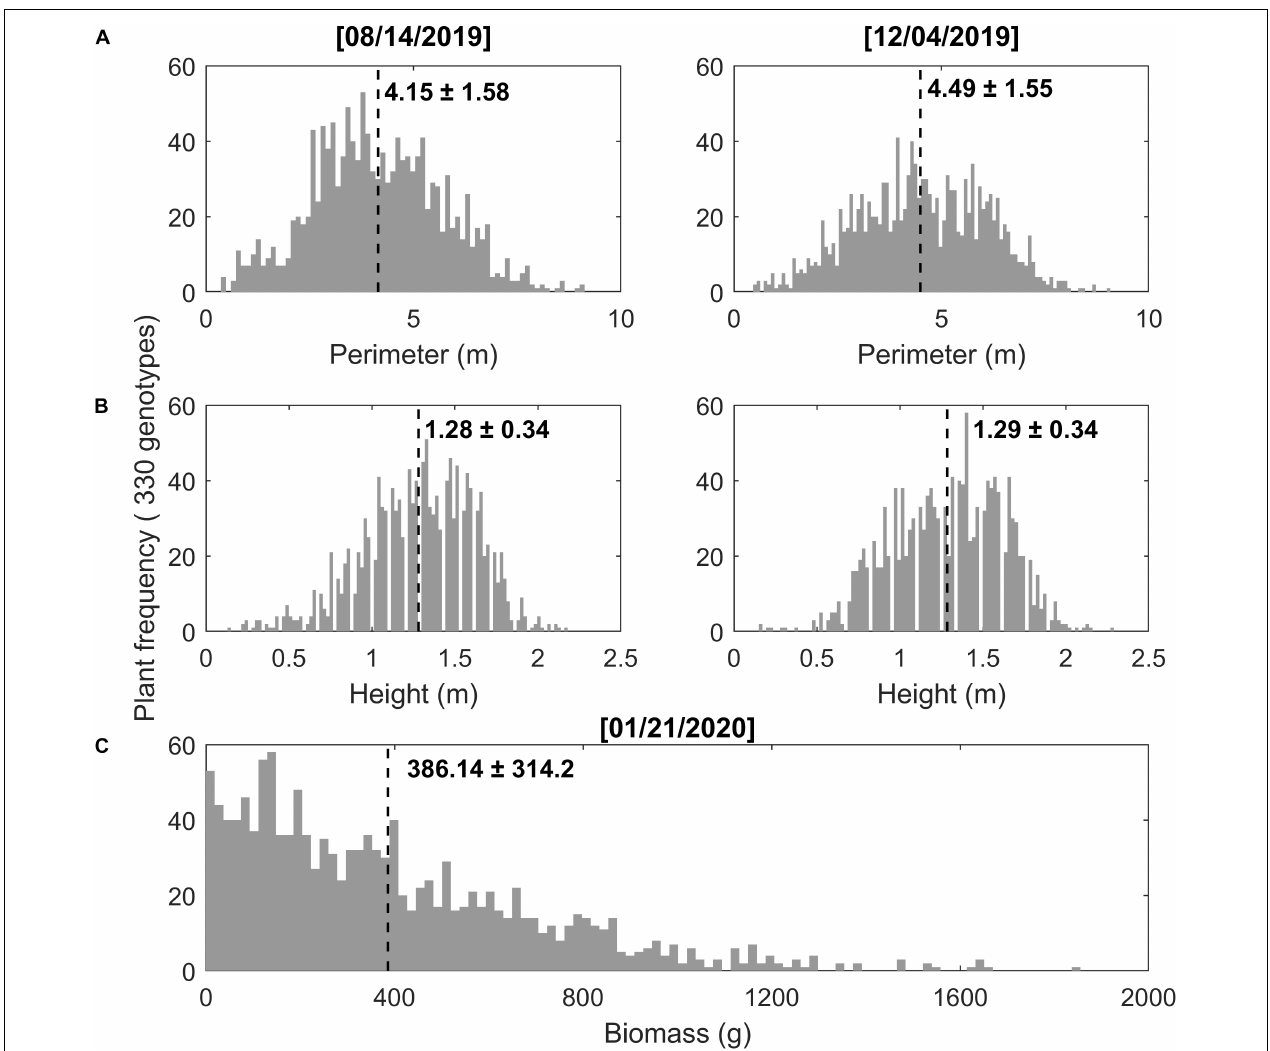
FIGURE 4 | Manual phenotyping measurements for 330 genotypes of switchgrass during mid-season (August 14, 2019) and end-of-season (December 04, 2019), as well as biomass harvest (January 21, 2020). (A) Plant perimeter, (B) plant height, and (C) plant biomass, where the numbers on the figure represent the mean and standard deviation (std) for 1,320 plants with 330 genotypes and four repetitions for each